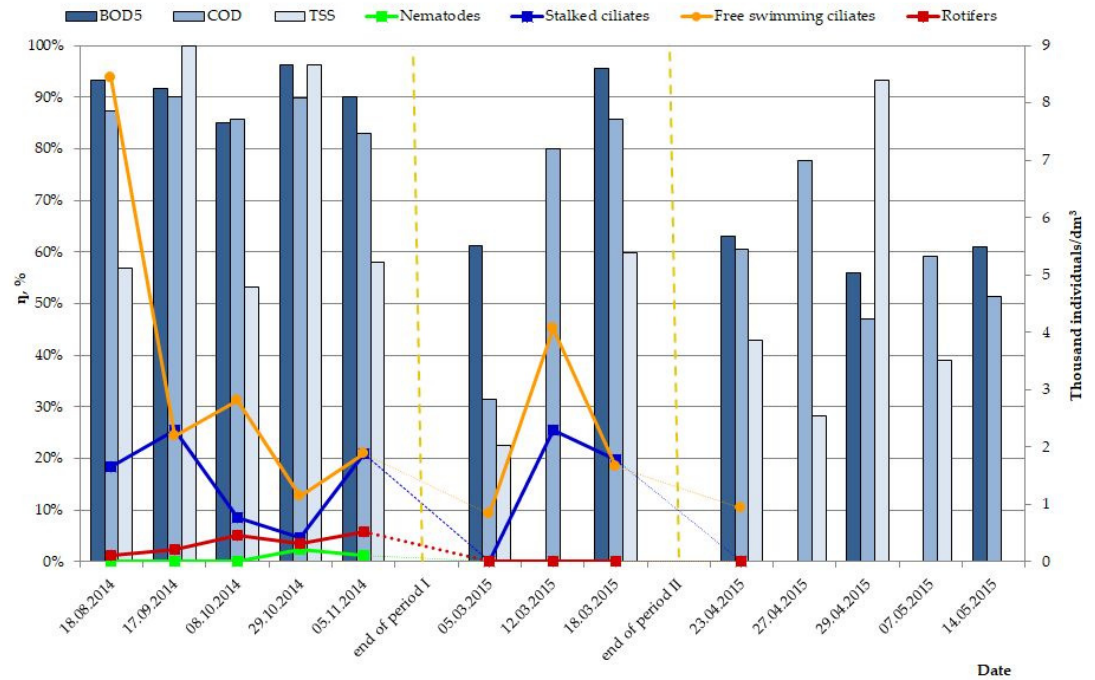
Figure 7. Abundance of organisms in activated sludge, efficiency of organic compounds removal, and efficiency of total suspended solids removal in WTP2.